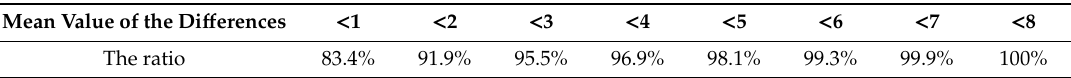
Table 2. The ratio of the mean values of the di ff erence values between the intensity level of NEI pixels and their surrounding